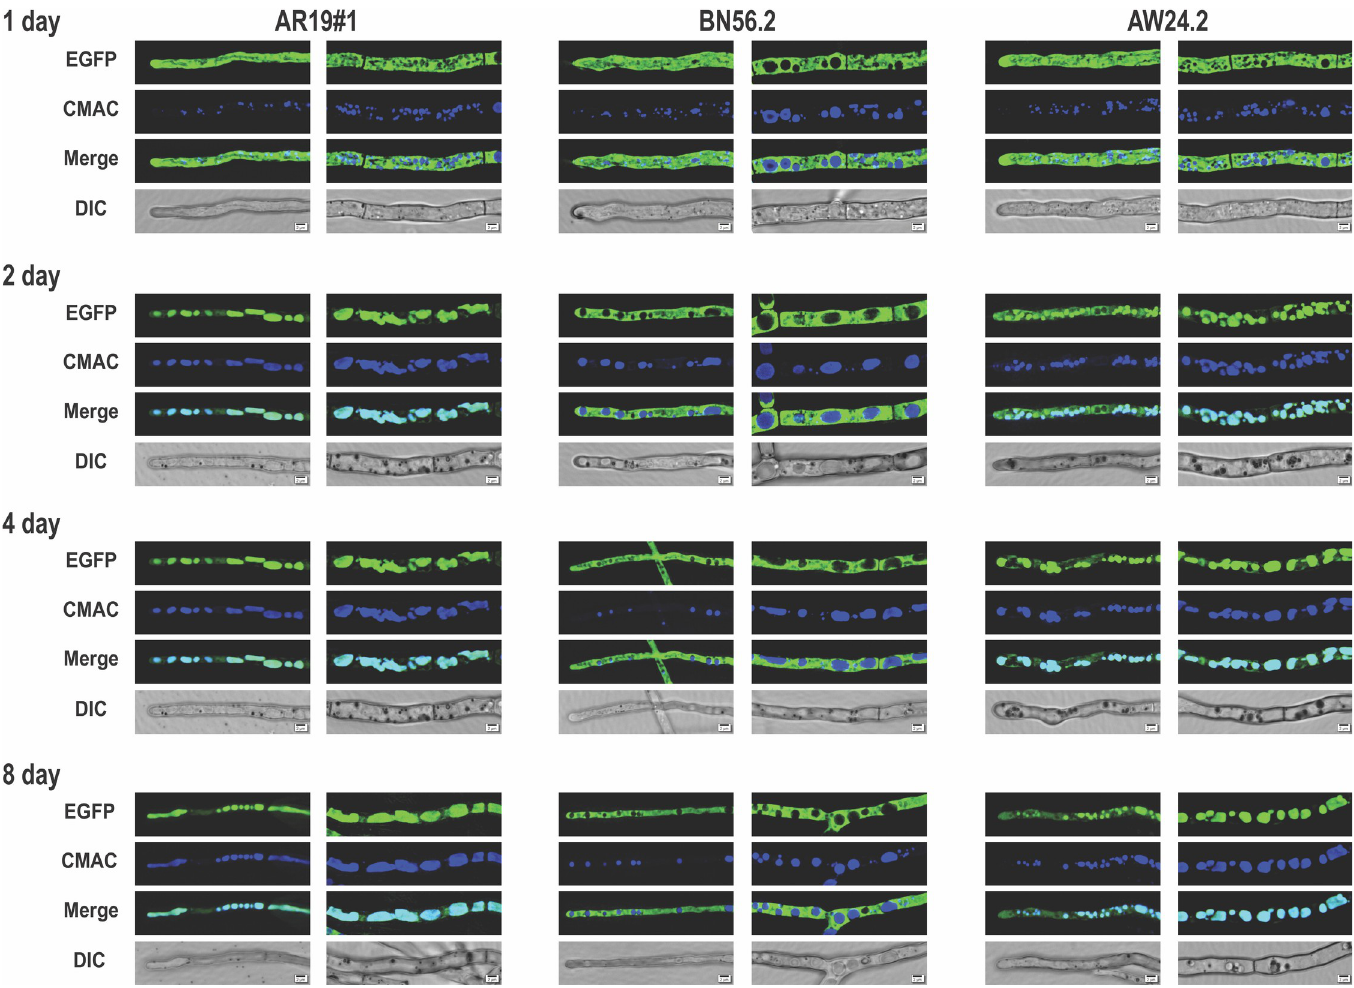
Fig 3. A . niger mycelial morphology during acidogenic growth. The morphology and EGFP fluorescence of A . niger strains, AR19#1 (wild type), BN56.2 ( Δ atg1 ) and AW24.2 ( atg1 complemented) was recorded on fermentation medium (AM) for 8 days. In each panel, the left frame shows the image of a tip cell and the right frame is of an intermediate cell. The mycelia were stained with CMAC when vacuoles appear blue; the vacuoles containing EGFP appear cyan on merge (scale bar = 2 μ m).